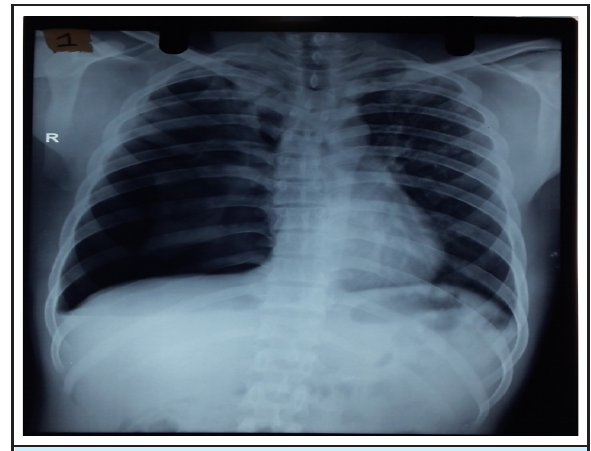
Figure 1. Right Pneumothorax.